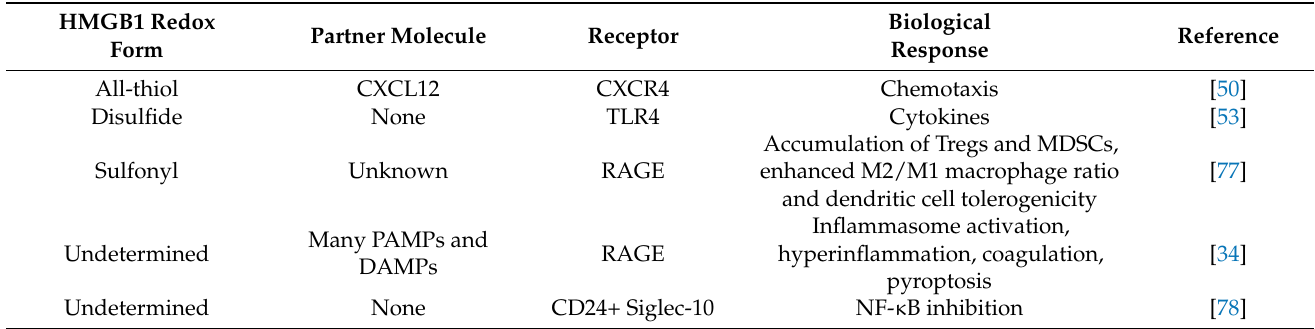
Table 1. Extracellular HMGB1 redox forms determine functional outcomes in inflammation.